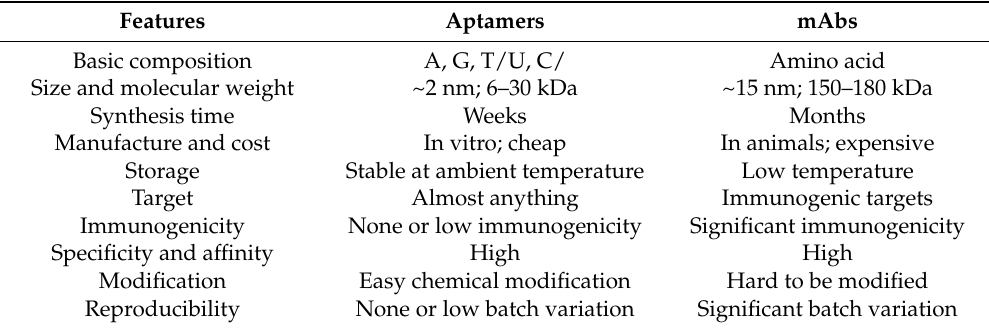
Table 1. Comparison between nucleic acid aptamers and monoclonal